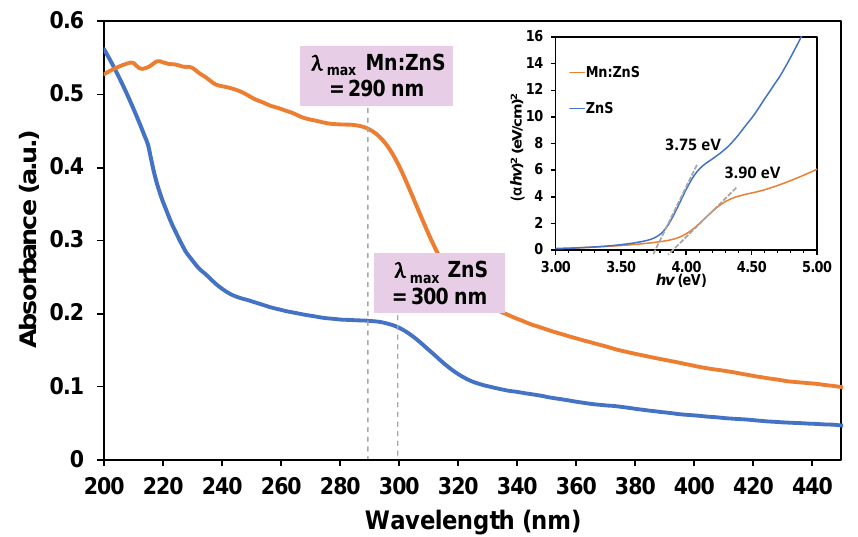
Figure 1. Comparison of UV–Vis spectra for ZnS and Mn:ZnS QDs (inset showing the Tauc’s plot for the same two samples).